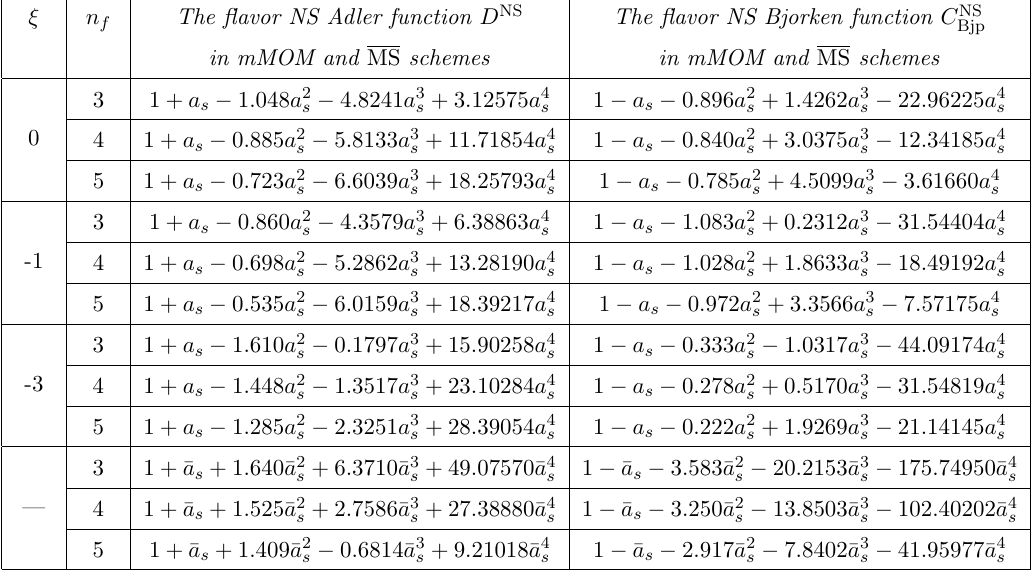
) PT expansions for the D NS and C NS s